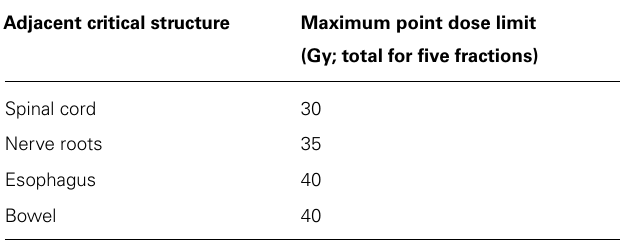
Table 1 | Institutional maximum point dose limit guidelines for adjacent critical